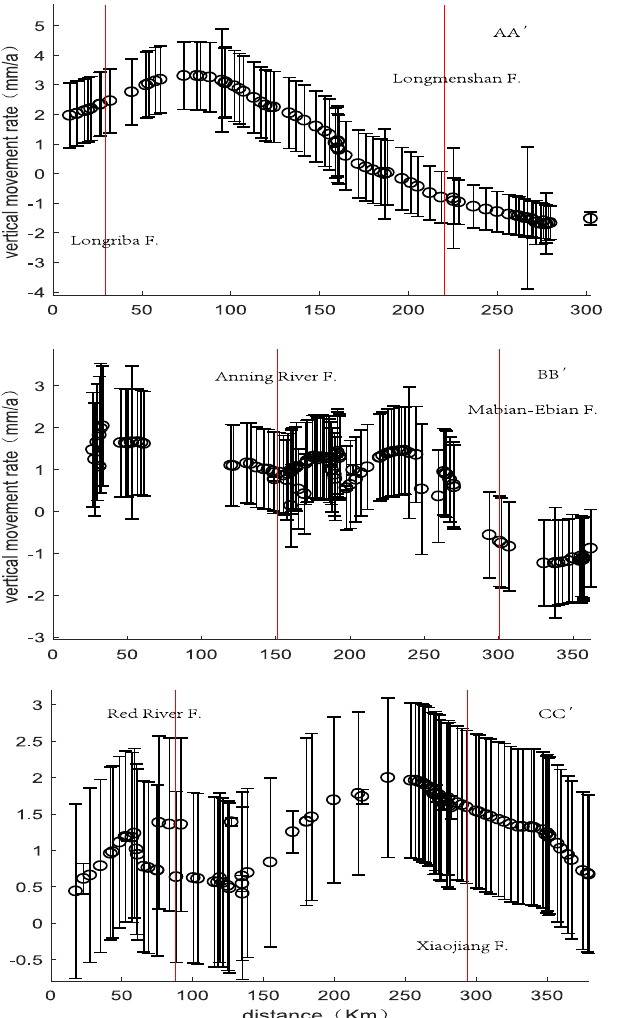
Figure 6. Three profiles, AA ′ , BB ′ and CC ′ , showing the vertical motions in the SYR . Profile locations are shown in Figure 1.